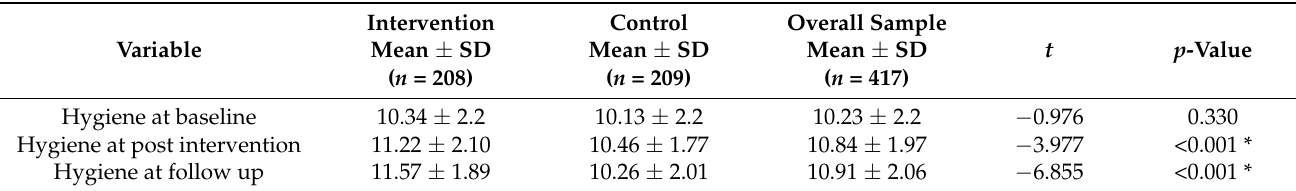
Table 3. Mean scores of WASH practice from baseline to follow up (3 months after intervention) between intervention and control group.